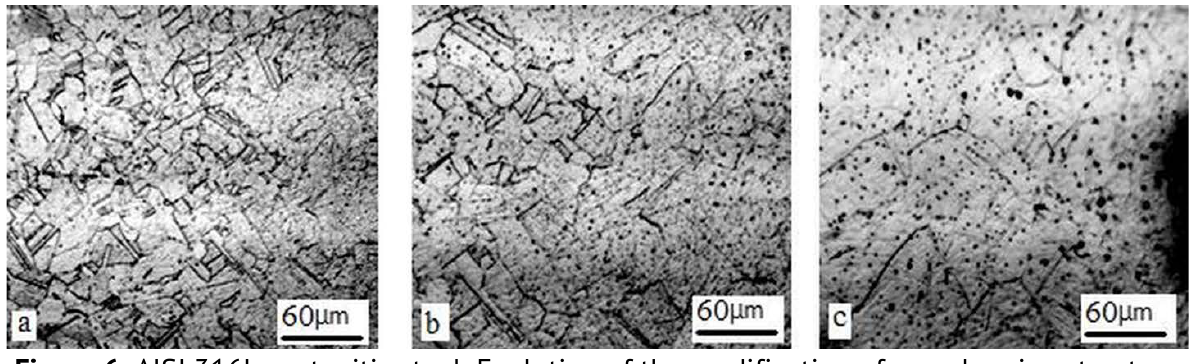
Figure 6. AISI 316L austenitic steel. Evolution of the modification of sample microstructure at a cross section as the surface approach (a - b - c) subjected to manual polishing for 5 hours.